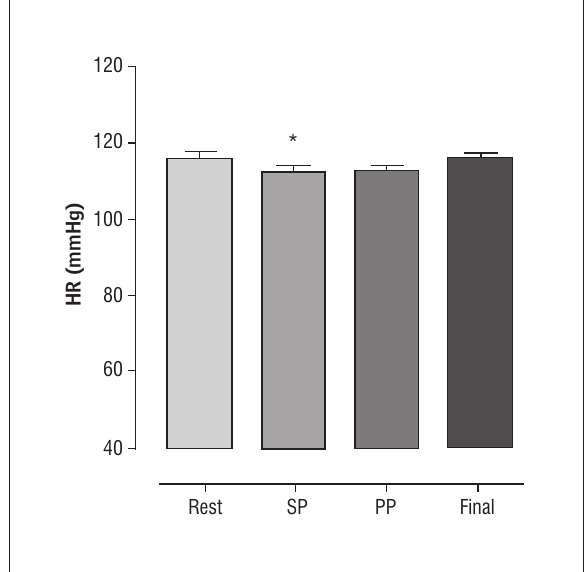
Figure 2 - Behavior of heart rate before, during and imme- diately after MLD Note: Supine position (SP); prone position (PP); heart rate